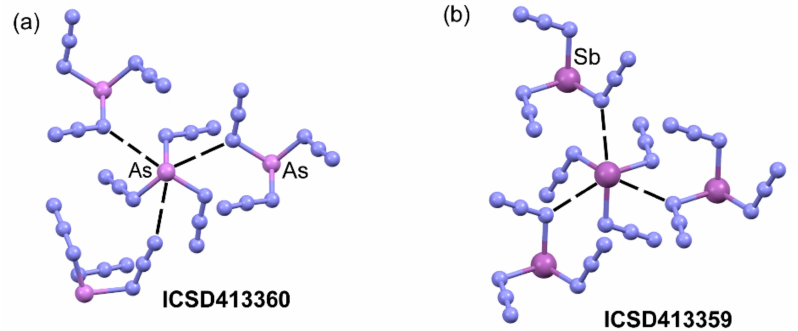
Figure 7. Ball-and-stick representation of ICSD413360 ( a ) and ICSD413359 ( b ) structures exhibiting PnBs, which are represented using dashed lines.